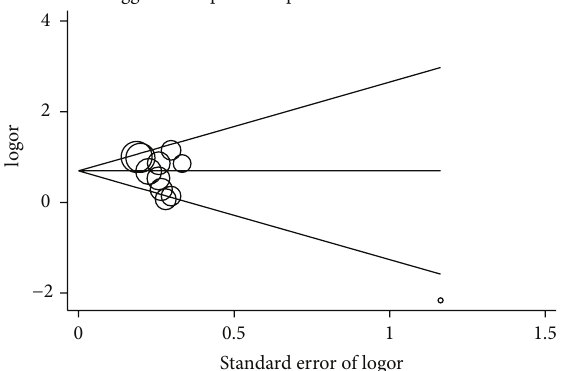
Figure 3: Begg’s funnel plot for publication bias test (TT versus GG for